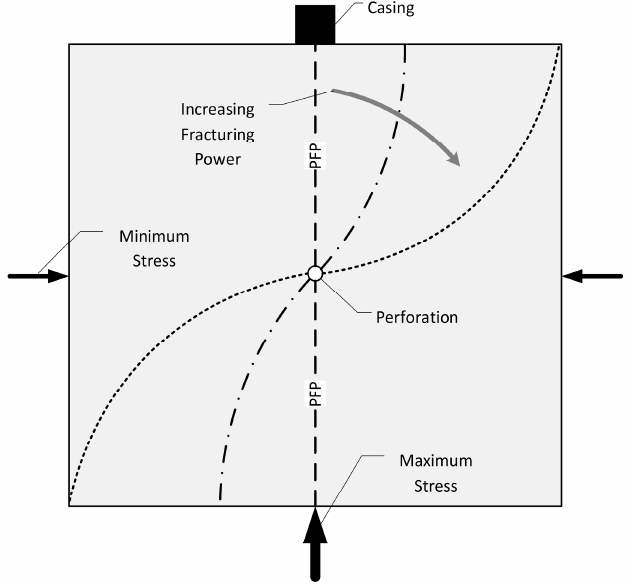
Figure 9. A schematic of the fracture initiation angle and propagation geometry in response to variation in the fracturing power.